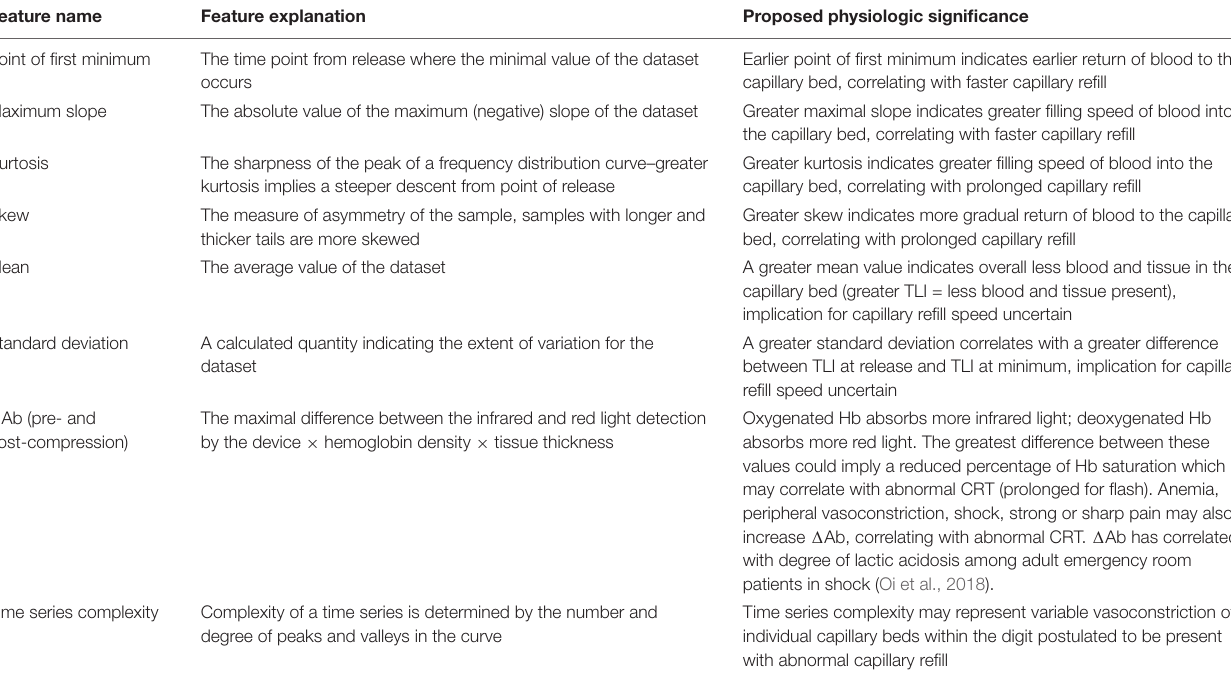
TABLE 4 | Graphical and physiologic explanation of model